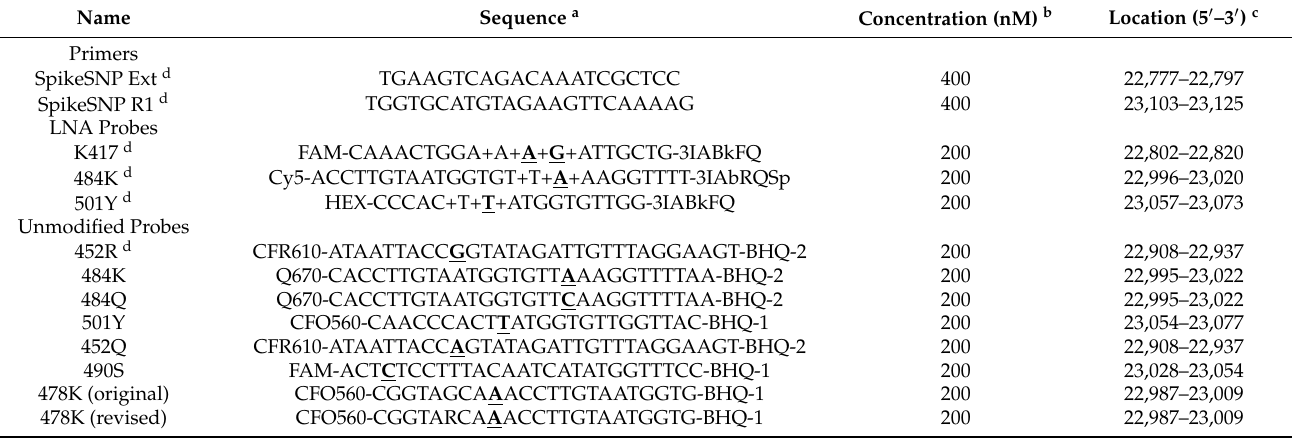
Table 1. Spike SNP assay primers and probes used in the current study.